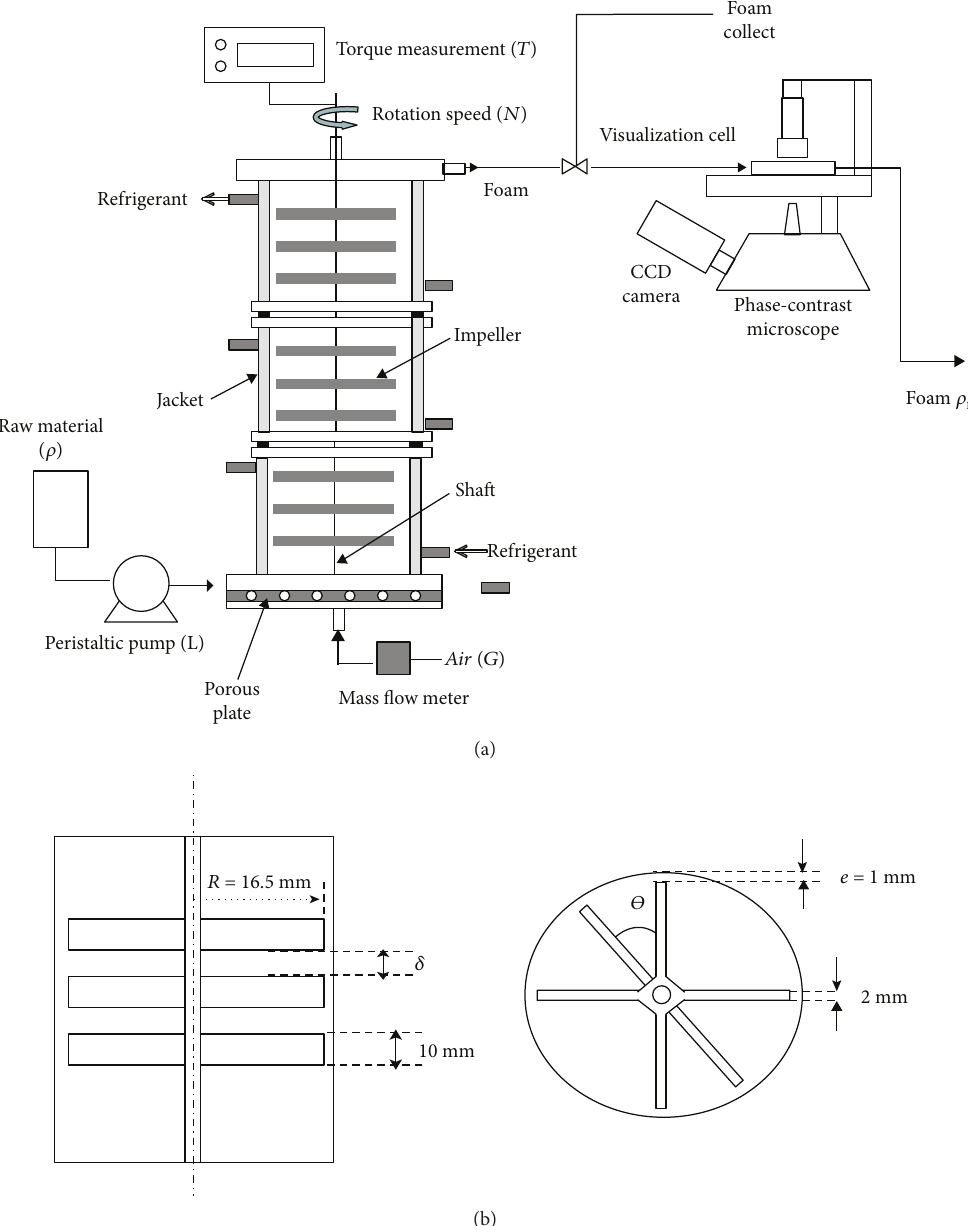
Figure 1: (a) Schematic diagram of a continuous experimental set-up for foam manufacturing and (b) fl at-bladed impellers of the NAGU [11,